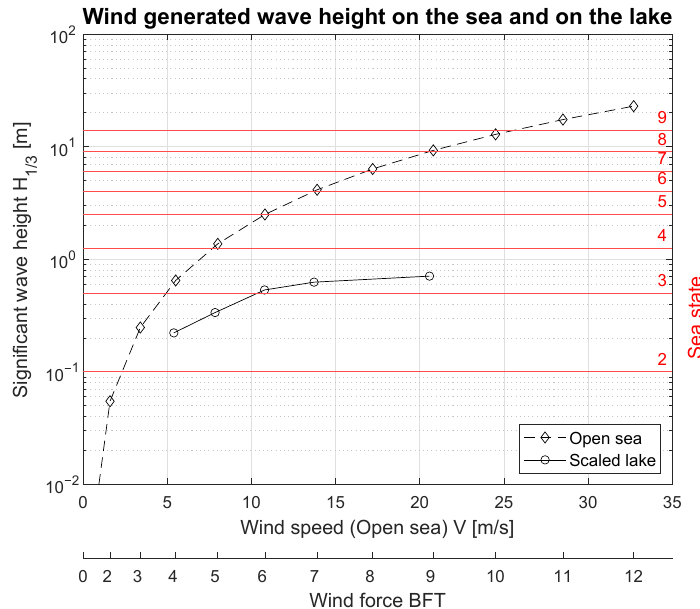
Figure 9. Significant wave height for the fully developed sea and for the lake as a function of the wind force in